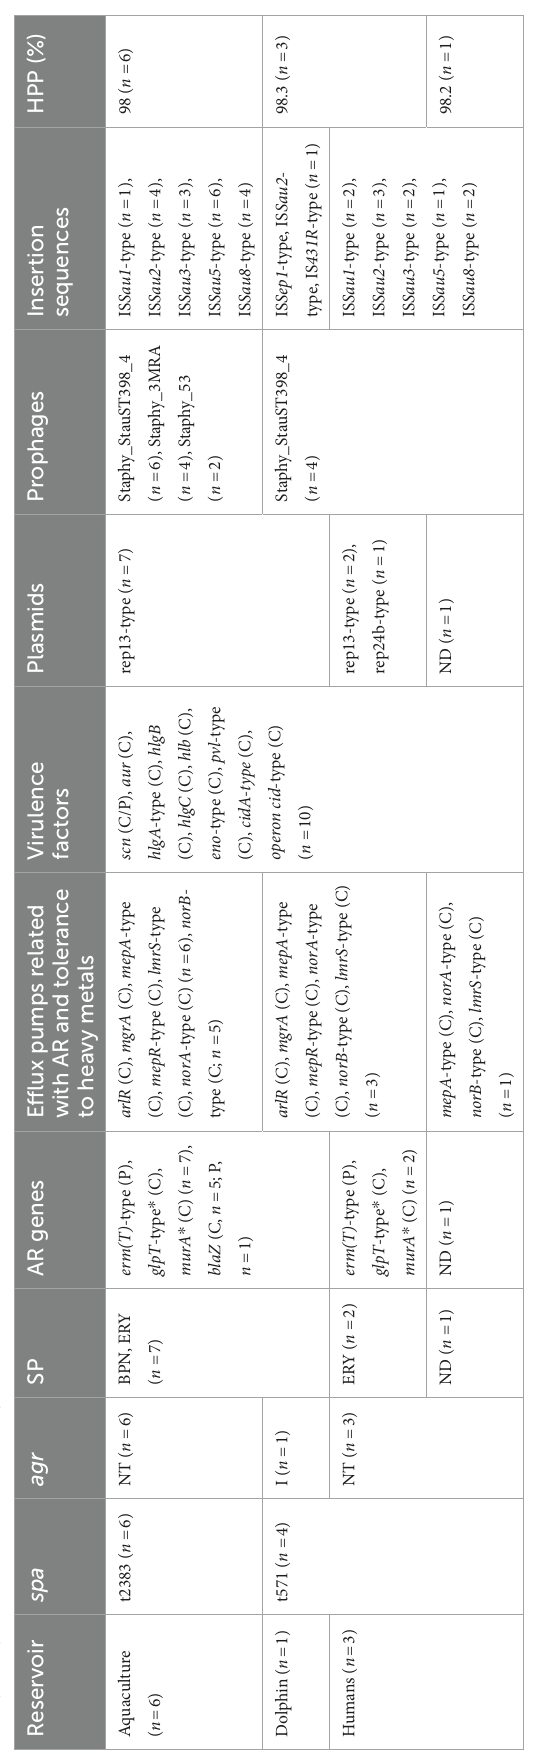
ST398 from humans in this study are very distinct from each other, which were collected in different years (minimum SNPs difference: 97 between INSa869 and INSa910; maximum SNPs difference: 149 between INSa869 and INSa934), and from the strains recovered from the dolphin and gilthead seabreams (minimum SNPs difference: 169 between INSa910 and INSaAq83; maximum SNPs difference between INSa934 and LV31741/INSaAq69; Supplementary Table S3). The strain isolated in a dolphin was also very distinct from the strains from gilthead seabream collected in an aquaculture farm (minimum SNPs difference: 178 with INSaAq83; maximum SNPs difference: 191 with INSaAq36). None of the strains with origin in the same aquaculture farm were indistinguishable, with a minimum SNPs difference of 3 (between INSaAq61 and INSaAq69/134 isolated in muscle and skin samples from 3 gilthead seabream) and a maximum SNPs difference of 33 (between INSaAq36 and INSaAq83 isolated both in muscle samples but from 2 different fish). Using the narrowest criteria (less than 15 SNPs), INSaAq83 is more closely related with INSaAq156 and the remaining strains from aquaculture with each other. Using the largest criteria (less than 50 SNPs), all strains from aquaculture origin are closely related. All these strains were from 5 gilthead seabream collected in the same aquaculture farm and possibly have a very recent common ancestor. Erythromycin and penicillins are considered by the World Health Organization (WHO) as “critically/highly important antimicrobials” and commonly used in humans, aquaculture settings and veterinary medicine (Santos and Ramos, 2018; WHO, 2018; ECDC, EFSA, EMA et al., 2021). In our study, seven strains were resistant to benzylpenicillin and nine out of 10 had an iMLS B phenotype (with resistance to erythromycin plus inducible resistance to clindamycin) and the erm(T) -type gene. The genetic environment of erm(T) -type gene in all the positive strains (Figure 3), was the same: upstream of erm(T) -type gene, the genetic environment was composed by a rep gene (involved in replication), a gene encoding a metalloregulator ArsR/SmtB family transcription factor (involved in tolerance/resistance to heavy metals, such as zinc, cadmium, cobalt, arsenic and antimony), cadD gene (that encodes for cadmium resistance transporter CadD) and ermCL gene (that regulates the expression of erm genes); downstream the gene, a plasmid truncated replication protein was identified (Busenlehner et al., 2003; Koch et al., 2017; Kwong et al., 2017). The only distinct feature was in S. aureus ST398 recovered from a dolphin (LV31741/11) that presented an IS 431R upstream the rep gene. All erm(T) -type genes were predicted to be located in plasmids, that may have played a role in the transmission between the different host species and environments. Six of the seven benzylpenicillin resistant strains with animal origin were positive for blaZ gene (except for INSAq83 isolated from muscle of gilthead seabream) and just one was predicted to be located in a plasmid (INSaAq156 isolated from gills of gilthead seabream). When analyzing the contigs that contained blaZ gene, we verified that the only difference between the strains from the gilthead seabream (excepting for INSaAq156) and the dolphin was the presence of phage’s genes in strains from aquaculture origin, namely Staphy_3MRA for INSaAq36, INSaAq61 and INSaAq134, and Staphy_53 for INSaAq69 (Table 1). The examination of the genetic environment nearby the blaZ gene (Figure 4) allow us to identify, upstream the gene in all strains, the two regulatory genes blaI and blaR1 controlling the blaZ expression (Takayama et al., 2018). All strains were susceptible to T A